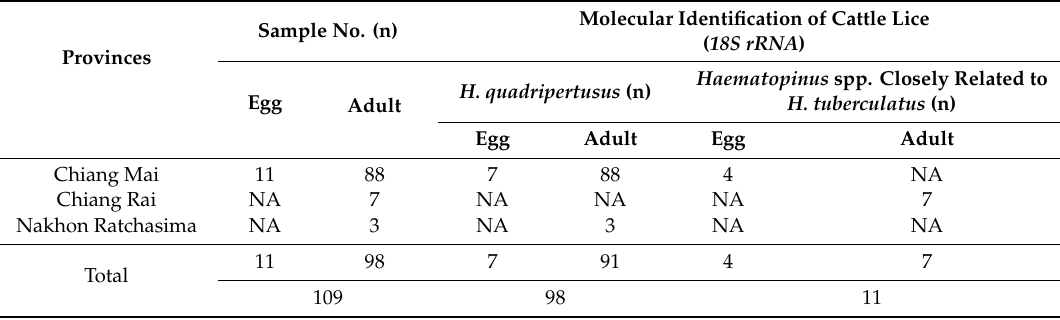
Table 1. Cattle lice samples collected from three di ff erent areas of